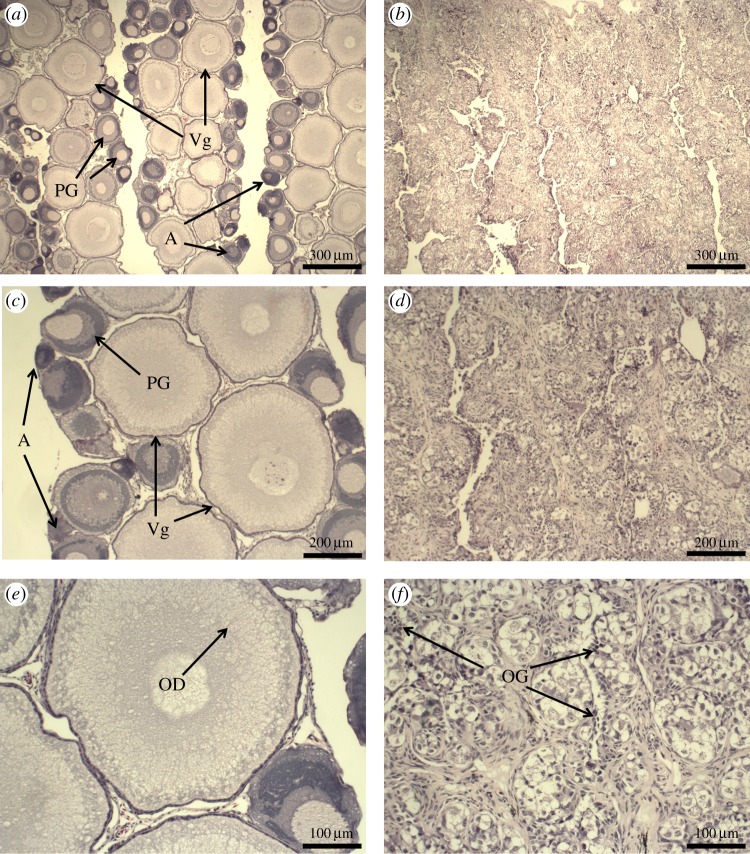
Histological sections of female diploid (n = 9) and triploid (n = 8) 2-year-old Atlantic salmon. (a,c,e) Diploid females containing oocytes at different stages of development (Vg, vitellogenic oocytes; PG, primary growth oocytes; A, atresia). Vitellogenic oocytes have accumulated oil droplets (OD). (b,d,f) Triploid females contained oogonia (OG), but ovaries are under-developed with the complete absence of maturing oocytes.